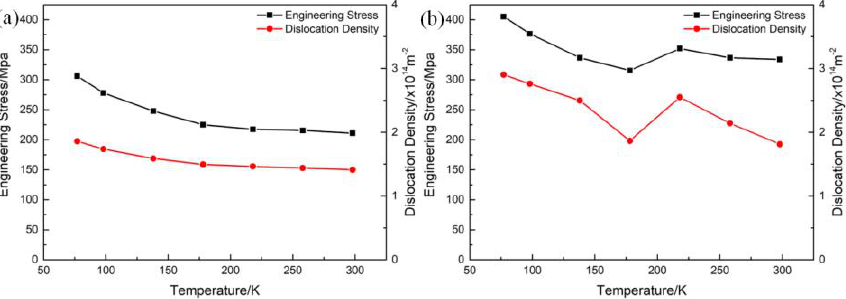
Figure 13. Deformation temperature-engineering stress and dislocation density curves of ( a ) the O-state alloy, ( b ) the W-state alloy.